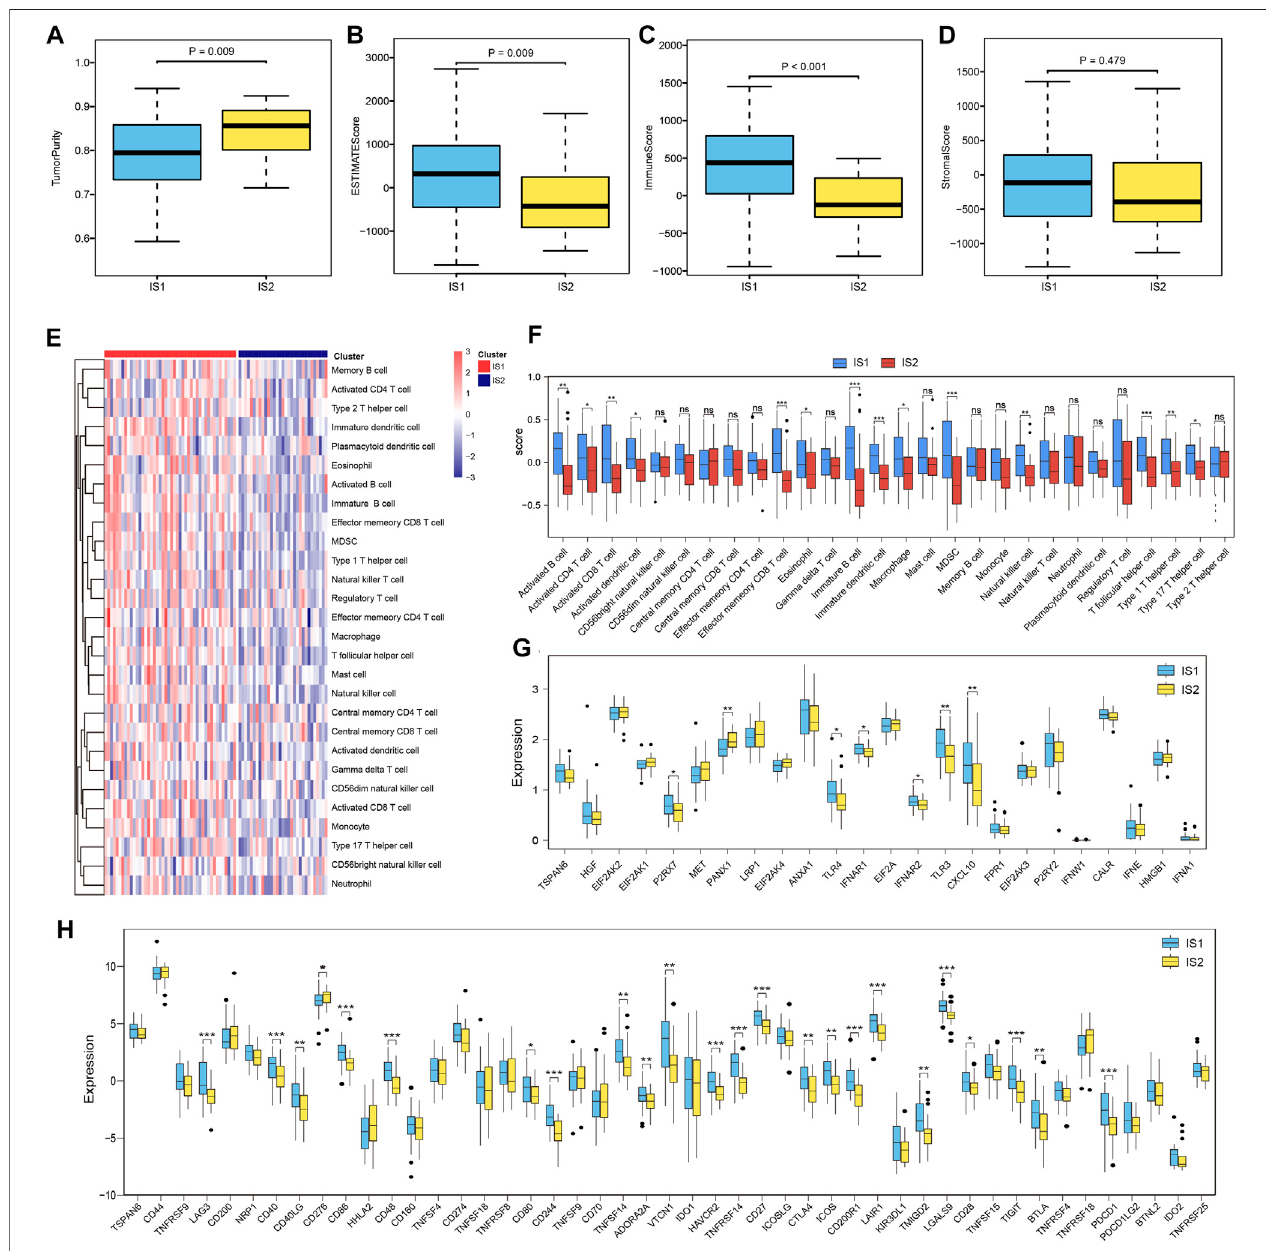
FIGURE 7 | Immune-related molecular characteristics in different subtypes. (A – D) Comparison of tumor purity, estimate score, immune score, and stromal score based on the ESTIMATE algorithm with different ESCC patient subtypes. (E) Heatmap showing the 28 immune cell signatures with differential enrichment score in IS1 and IS2 subtypes. (F) Boxplot showing the differential enrichment score according to the 28 immune cell signatures in IS1 and IS2 subtypes. (G) Boxplot showing the differential expression of ICPs in the IS1 and IS2 subtypes. (H) Boxplot showing the differential expression of ICDs in IS1 and IS2 subtypes.